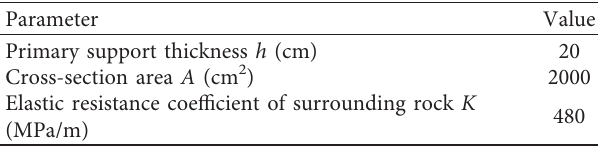
Table 2: Tunnel section parameters.